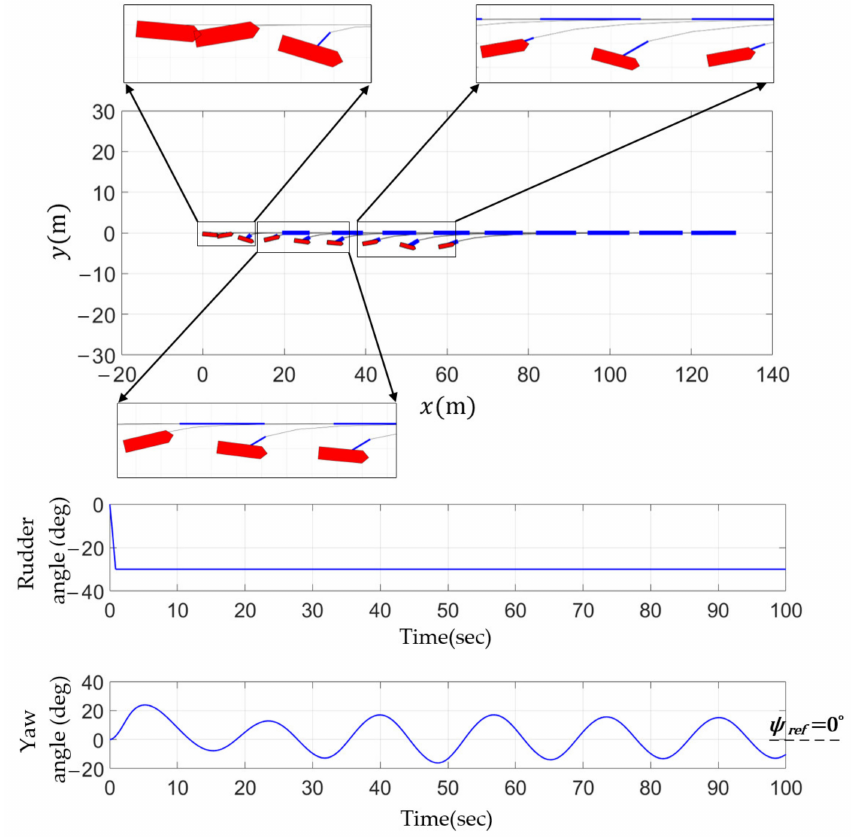
Figure 17. Simulation results when yaw control is applied at point marked with a